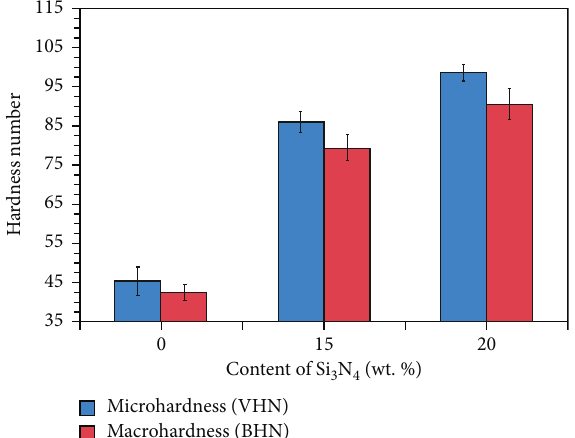
3 N 4 composite and (b) AA6061/20 wt.% Si 3 N 4